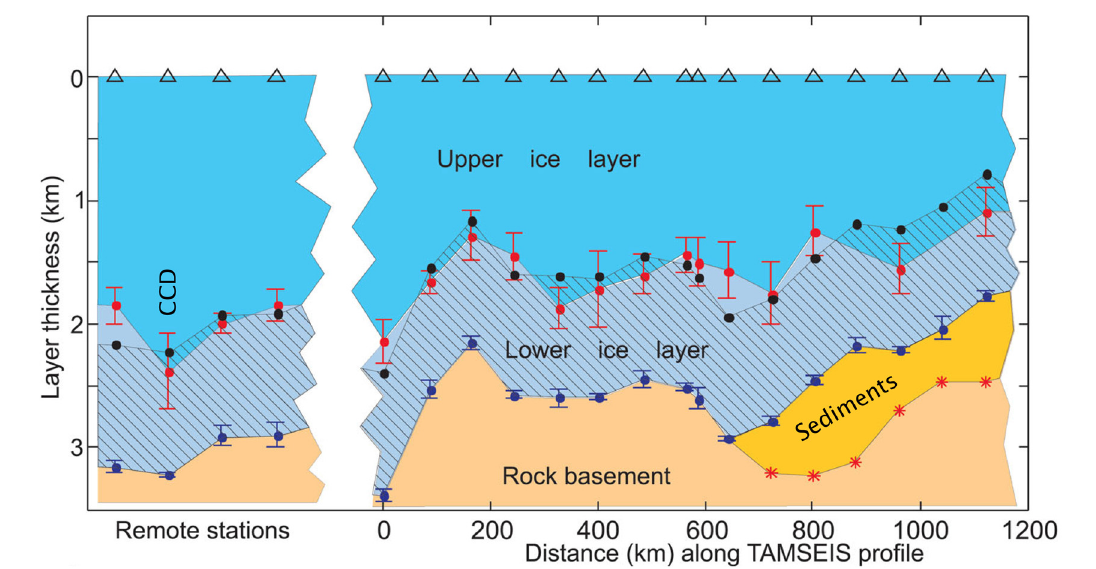
Figure 10. Two-layer ice structure in East Antarctica and Greenland from P-wave receiver functions (after Wittlinger and Farra [2012]). The hatched area has a constant thickness equal to the mean thickness of the lower layer. Remote stations (left) are from left to right: SUMG (Greenland), CCD (Concordia), QSPA (South Pole) and P061 (a Polenet station, see Figure 11a). Other stations are from the TAMSEIS ex- periment